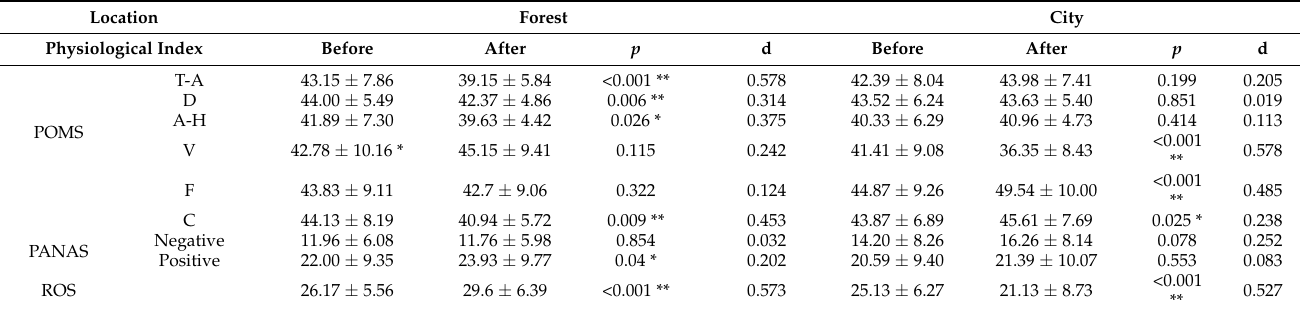
Table 6. Review of previous studies comparing digital forest bathing.